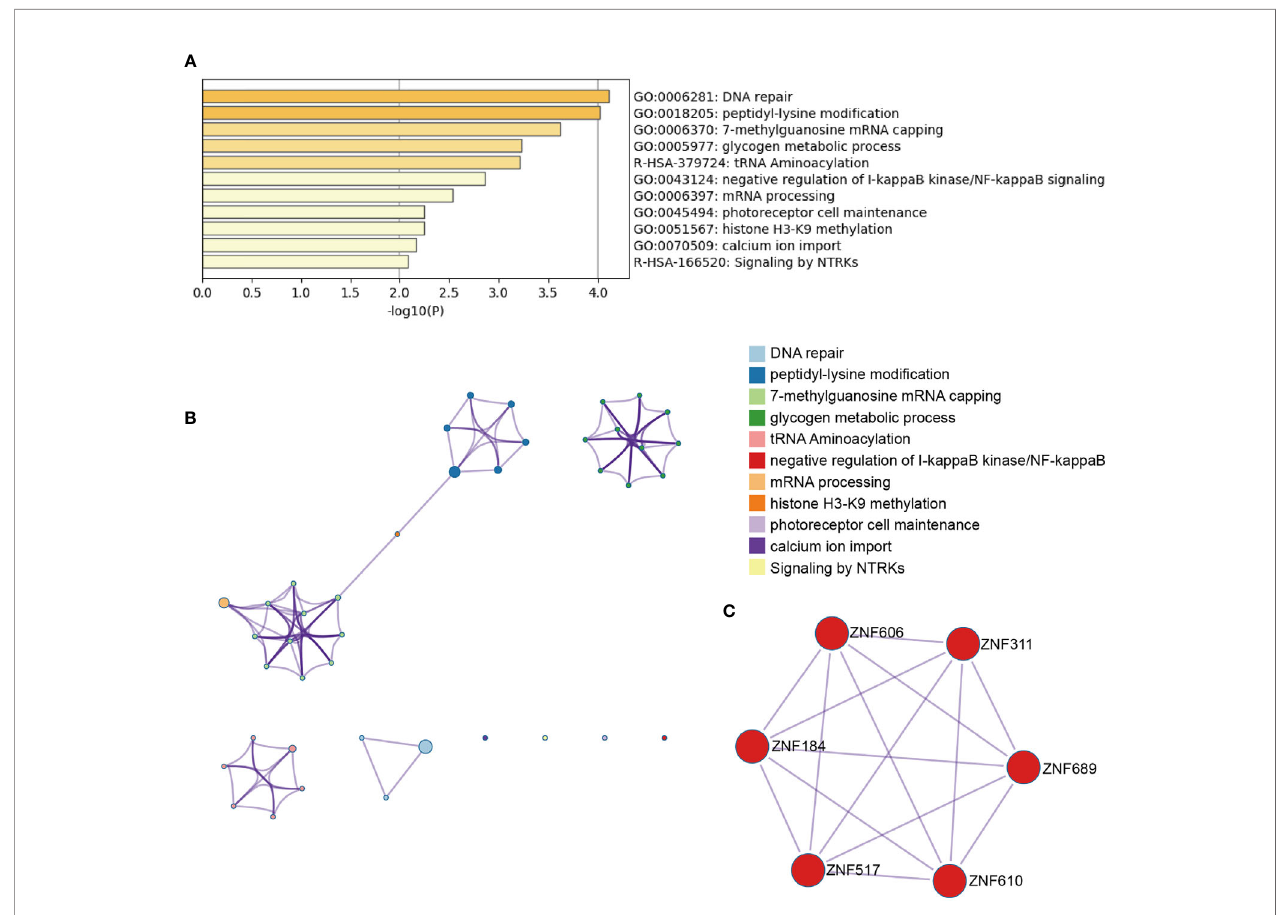
FIGURE 3 | Gene enrichment analysis of the AL138831.2-signature. (A) The histogram of the top 11 enriched pathways associated with risk score in AL138831.2 was arranged by -Log10P value. Each bar represented one enriched term and was coloured by -Log10P value; (B) Using Metascape to cluster the pathways related with AL138831.2. The top 11 enriched pathways were shown (right panel); (C) The pathways related with AL138831.2 were clustered by MCODE ZNF